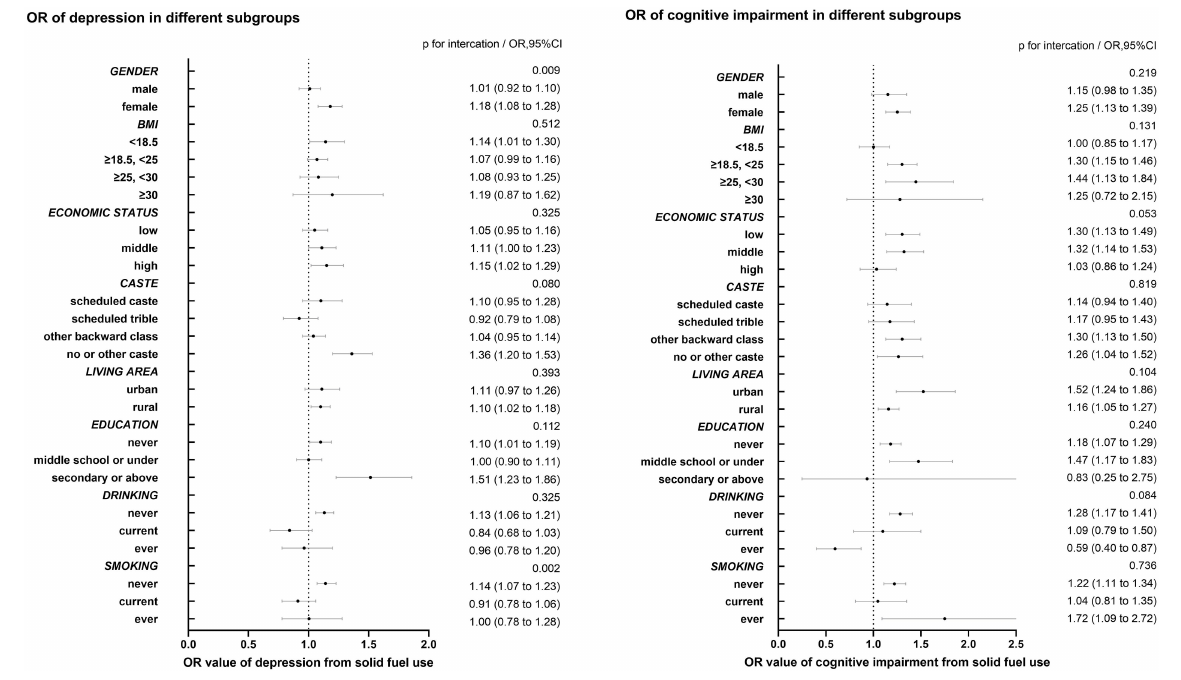
FIGURE2 Subgroup analysis in the association of solid fuel use with depression and cognitive impairment. Subgroup analysis were adjusted by age, gender, BMI, education, marriage, live age, whether works, caste, religion, economic status, drinking, smoking, sleep disorder, CCDs, vigorous physical activity, other indoor pollution, indicators of poor housing